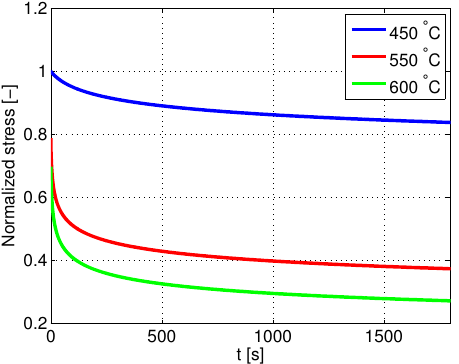
Figure 5. The temperature dependent stress relax- ation